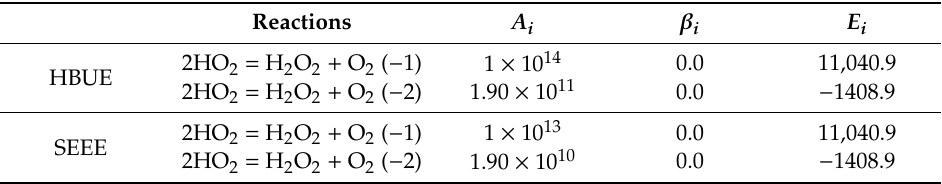
Table 2. Optimized reactions from HBUE to